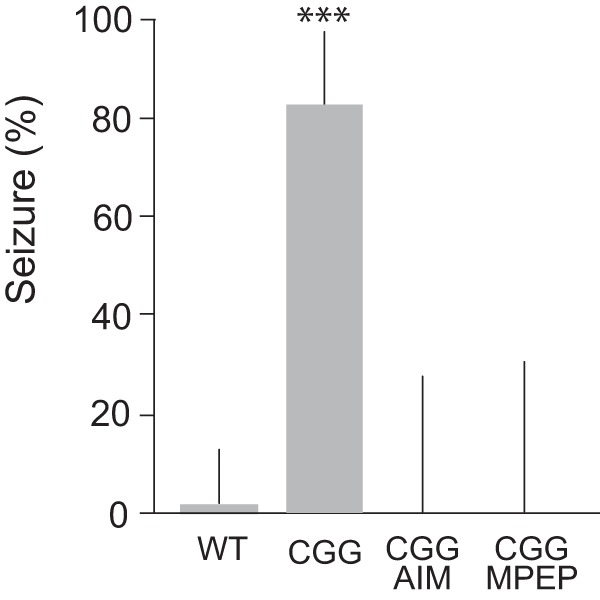
Audiogenic seizures in CGG animals. Significantly increased propensity for audiogenic seizures was observed with CGG mice (n = 42), in comparison with WT mice (n = 30). Seizures were not observed in CGG mice injected with anisomycin (75 mg/kg i.p.; n = 12) or MPEP (40 mg/kg i.p.; n = 10). Fisher’s exact test, p < 0.001. Error bars represent 95% confidence intervals.